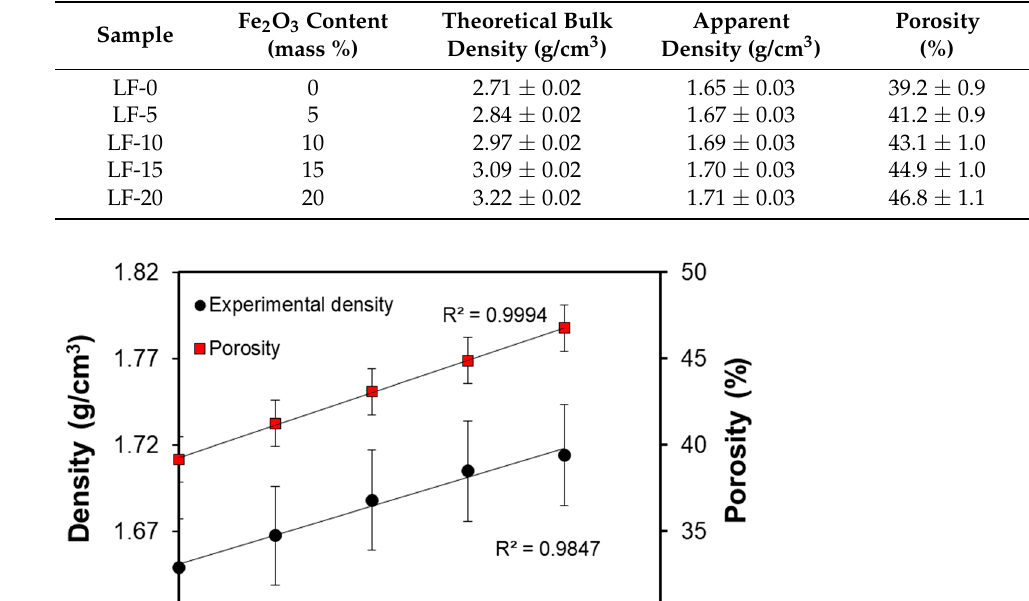
Table 3. Bulk and apparent densities and porosity of the samples with different iron (III) oxide con- tent.